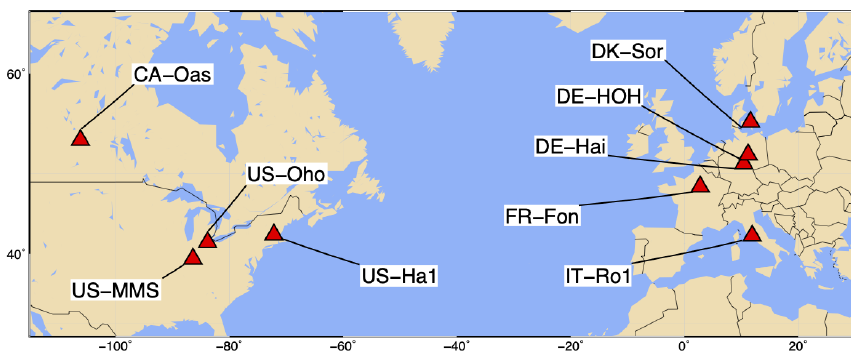
Figure 2. Location of the FLUXNET2015 sites investigated in this study. Table 1. Descriptions of flux tower sites from FLUXNET2015 global database collection. Note that, since the phenology submodel for sim- ulating budburst in each year needs the temperature data from the last 10–11 days of the previous year, the very first year of the investigation period at each site is not included in the